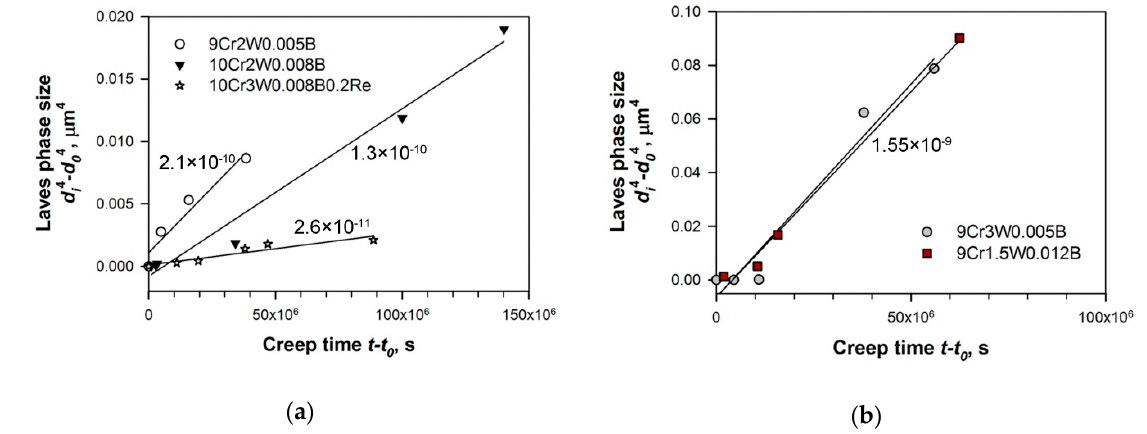
Figure 9. The time dependence of the size of Laves phase for: ( a ) the 9Cr2W0.005B, 10Cr2W0.008B, and 10Cr3W0.008B0.2Re steels; ( b ) the 9Cr3W0.005B and 9Cr1.5W0.012B steels. Numbers indicate the coarsening rate constant (in µ m 4 s − 1 ).